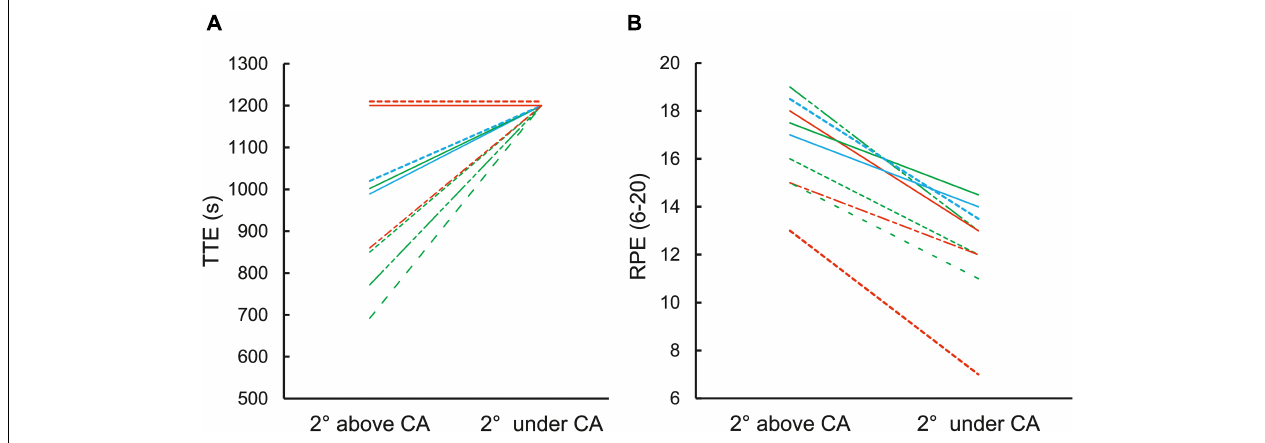
FIGURE 3 | (A) TTE during climbing 2 ◦ above and under CA. The time of 20 min (1,200 s) was set as maximal irrespective exhaustion occurred or not. Immediately after the climb, RPE was assessed in both conditions (B) . Color of individual lines represents climbers with different level of W (cid:48) : red (W (cid:48) > 3,500 ◦ s), blue (W (cid:48) > 2,500–3,500 ◦ s), green (W (cid:48) < 2,500 ◦ s).